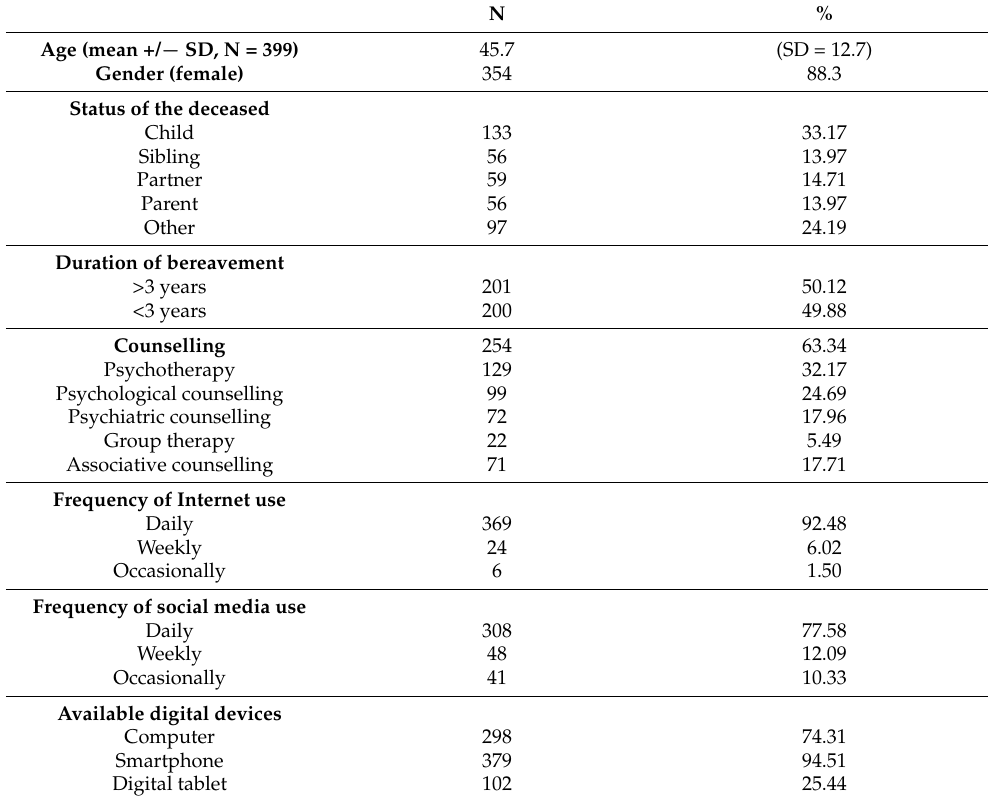
Table 1. Characteristics of the